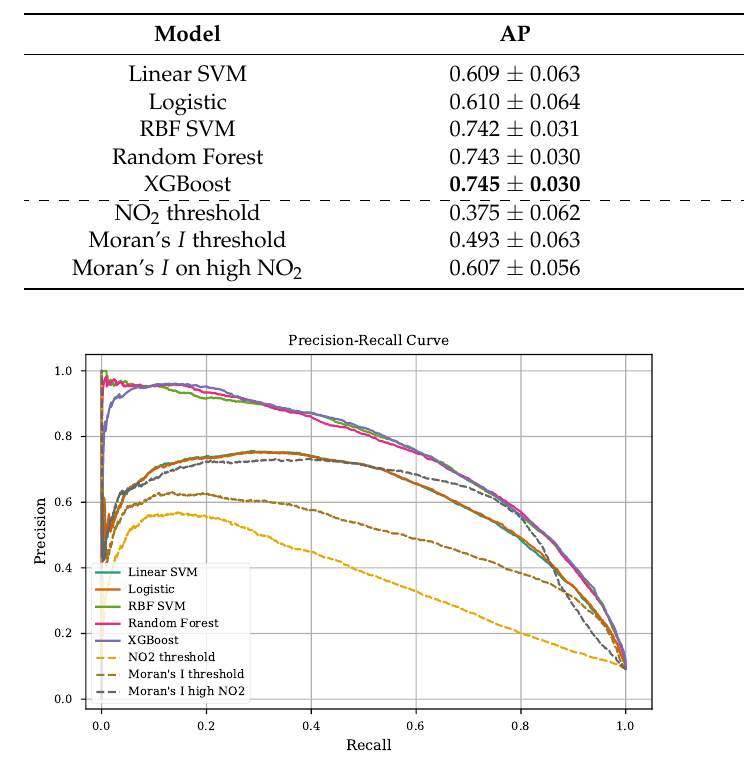
Table 3. Results on the test set with 5-fold cross-validation. Bold font indicates the best-obtained result. Under the dashed line: results obtained from univariate threshold-based methods that, in this study, we considered as benchmarks.